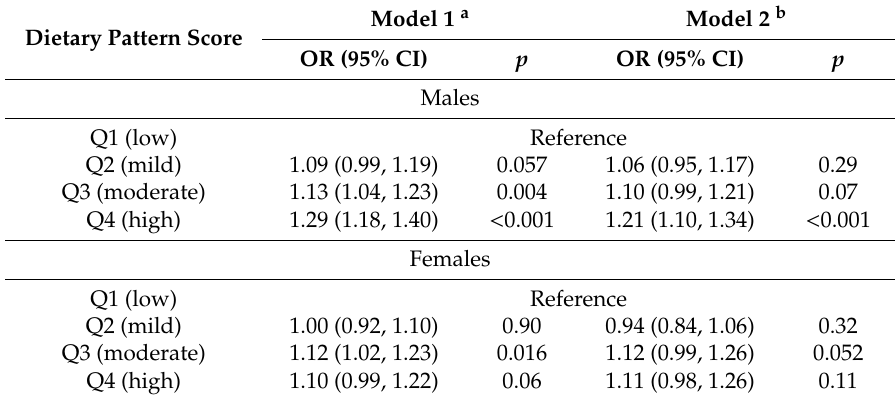
Table 2. Association between quartiles of inflammatory dietary pattern scores and dyslipidemia. Model 1 a Dietary Pattern Score